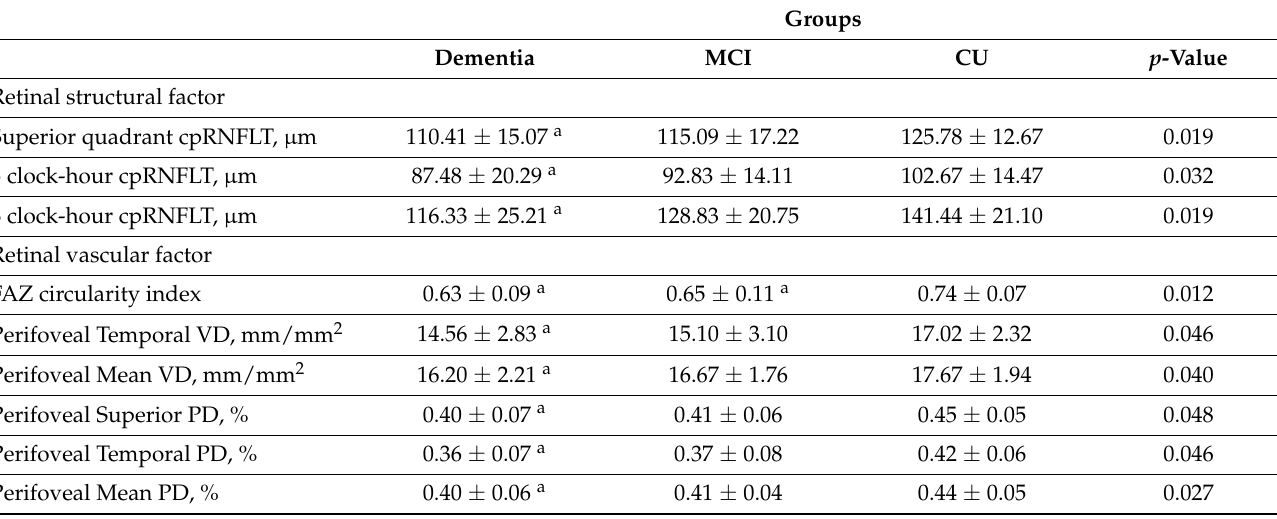
Table 2. Comparison of OCT and OCT angiography parameters in three groups.